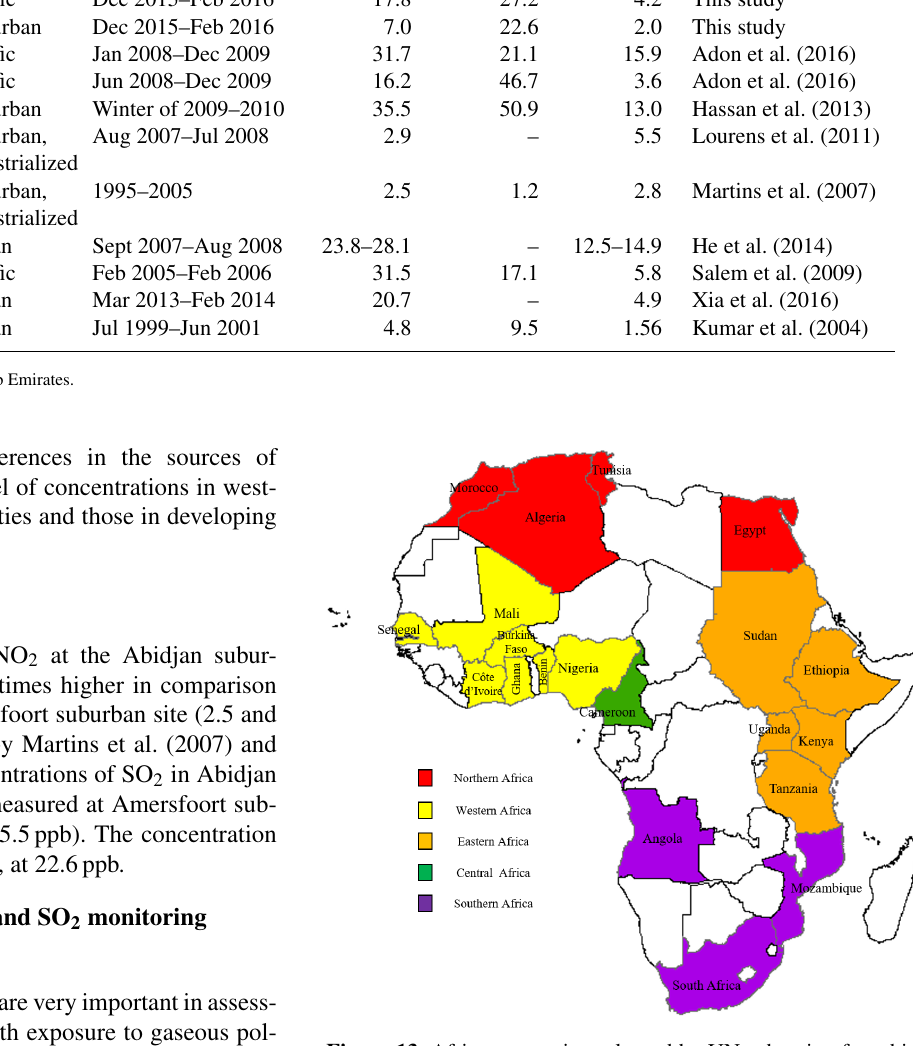
Figure 13. African countries coloured by UN subregion for which NO 2 and SO 2 studies were identified and included in this publica-